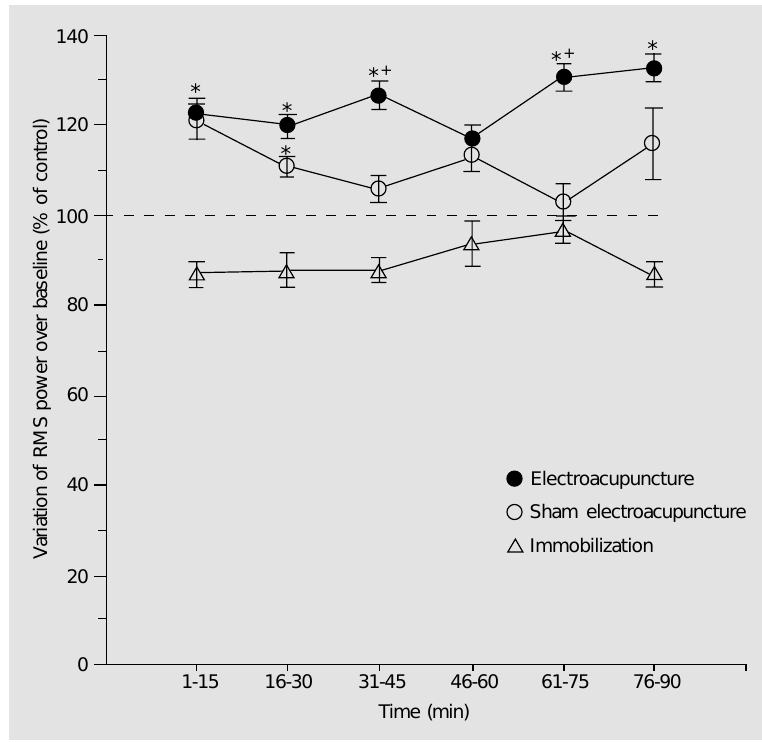
Figure 3. Variation of root mean square (RMS) power over baseline recordings of the intestinal myoelectric activity as measured over time in 6 consecutive time bins (each bin of 15-min duration). Electroacupuncture (N = 13, filled circles), animals subjected to electro- acupuncture at points ST-36 ( Zusanli ) and SP-6 ( Sanyinjiao ); sham electroacupuncture (N = 14, open circles), animals with needle inserted and stimulated at non-acupuncture points; immobilized (N = 11, triangles), animals subjected only to immobilization. P = 0.0001 (repeated measures ANOVA).